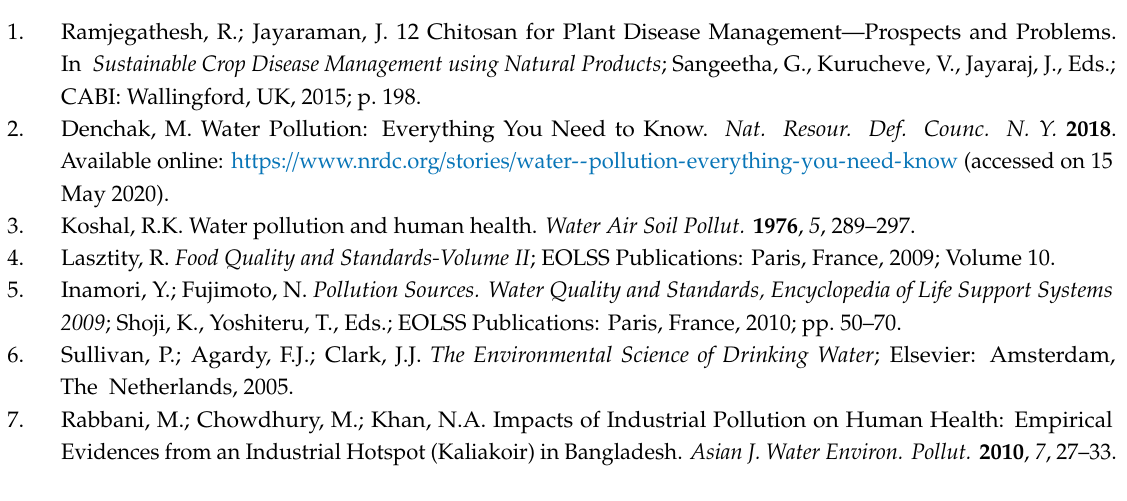
the adsorption process. Figure S33: EDX pattern of Ch-ZnSO 4 (c 0 = 5200 mg · L − 1 ) after the adsorption process. Figure S34 SEM–EDX images of (a) Ch-MnCl 2 c 0 = 4100 mg · L − 1 (distribution of Cl, top corner right-hand-side), (b) Ch-CoCl 2 c 0 = 4000 mg · L − 1 (distribution of Cl, top corner right-hand-side), (c) Ch-Mn(NO 3 ) 2 c 0 = 5800 mg · L − 1 , (d) Ch-Co(NO 3 ) 2 c 0 = 6200 mg · L − 1 , (e) Ch-MnSO 4 c 0 = 5900 mg · L − 1 (distribution of S, top corner right-hand-side), and (f) Ch-CoSO 4 c 0 = 4800 mg · L − 1 (distribution of S, top corner right-hand-side) after the adsorption process, scale bar: 3 µ m. Figure S35: SEM–EDX images of (a) Ch-NiCl 2 c 0 = 4200 mg · L − 1 (distribution of Cl, top corner right-hand-side), (b) Ch-CuCl 2 c 0 = 4000 mg · L − 1 (distribution of Cl, top corner right-hand-side), (c) Ch-Ni(NO 3 ) 2 c 0 = 6200 mg · L − 1 , (d) Ch-Cu(NO 3 ) 2 c 0 = 5800 mg · L − 1 , (e) Ch-NiSO 4 c 0 = 5600 mg · L − 1 (distribution of S, top corner right-hand-side), and (f) Ch-CuSO 4 c 0 = 4700 mg · L − 1 (distribution of S, top corner right-hand-side) after the adsorption process, scale bar: 3 µ m. Figure S36: SEM–EDX images of (a) Ch-ZnCl 2 c 0 = 4100 mg · L − 1 (distribution of Cl, top corner right-hand-side), (b) Ch-FeCl 2 c 0 = 650 mg · L − 1 , (c) Ch-Zn(NO 3 ) 2 c 0 = 3800 mg · L − 1 , (d) Ch-Fe(NO 3 ) 2 c 0 = 410 mg · L − 1 , (e) Ch-ZnSO 4 c 0 = 5200 mg · L − 1 (distribution of S, top corner right-hand-side), and (f) Ch-FeSO 4 c 0 = 5900 mg · L − 1 (distribution of S, top corner right-hand-side) after the adsorption process, scale bar: 3 µ m. Figure S37: Zetapotential measurement as a function of pH for Ch85 / 400 / A2. Figure S38 Column experiment as c t / c 0 vs. time plot with all six heavy metal sulfate salts. The column was filled with the chitosan flakes and the concentration of the heavy metal ions and sulfate was measured as a function of time, including the change in pH. The initial concentrations of each heavy metal ion in the solution was c 0 (Mn 2 + ) = 4.06 mmol · L − 1 ; c 0 (Fe 2 + ) = 4.05 mmol · L − 1 ; c 2 + ) = 4.08 mmol · L − 1 ; c 2 + ) = 3.91 mmol · L − 1 ; c 2 + ) = 3.97 mmol · L − 1 ; c 2 + ) = 0 (Co 0 (Ni 0 (Cu 0 (Zn 3.93 mmol · L − 1 ; and c 0 (SO 42 − ) = 28.64 mmol · L − 1 . Figure S39: Column experiment as q(t) vs. time plot with all six heavy metal sulfate salts. The column was filled with the chitosan flakes and the concentration of the heavy metal ions and sulfate was measured as a function of time, including the change in pH. The initial concentrations of each heavy metal ion in the solution was c 0 (Mn 2 + ) = 4.06 mmol · L − 1 ; c 0 (Fe 2 + ) = 4.05 mmol · L − 1 ; c 0 (Co 2 + ) = 4.08 mmol · L − 1 ; c 0 (Ni 2 + ) = 3.91 mmol · L − 1 ; c 0 (Cu 2 + ) = 3.97 mmol · L − 1 ; c 0 (Zn 2 + ) = 3.93 mmol · L − 1 ; and c 0 (SO 42- ) = 28.64 mmol · L − 1 . Table S2: Adsorption capacities for removal of manganese compounds from aqueous solutions with di ff erent adsorber materials. Table S3: Adsorption capacities for removal of iron compounds from aqueous solutions with di ff erent adsorber materials. Table S4: Adsorption capacities for removal of cobalt compounds from aqueous solutions with di ff erent adsorber materials. Table S5: Adsorption capacities for removal of nickel compounds from aqueous solutions with di ff erent adsorber materials. Table S6: Adsorption capacities for removal of copper compounds from aqueous solutions with di ff erent adsorber materials. Table S7: Adsorption capacities for removal of zinc compounds from aqueous solutions with di ff erent adsorber